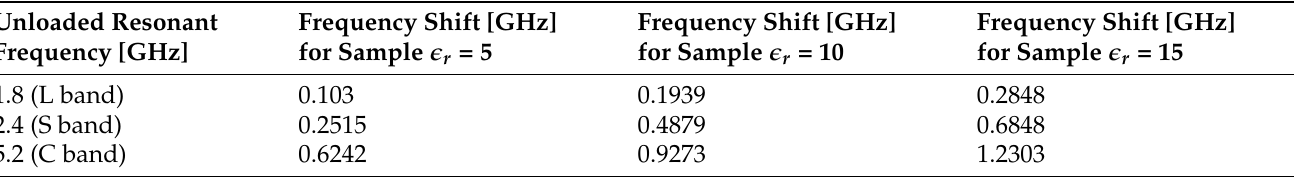
Table 15. Frequency shift in various frequency bands on varying the dielectric permittivity of samples loaded on to the sensor.